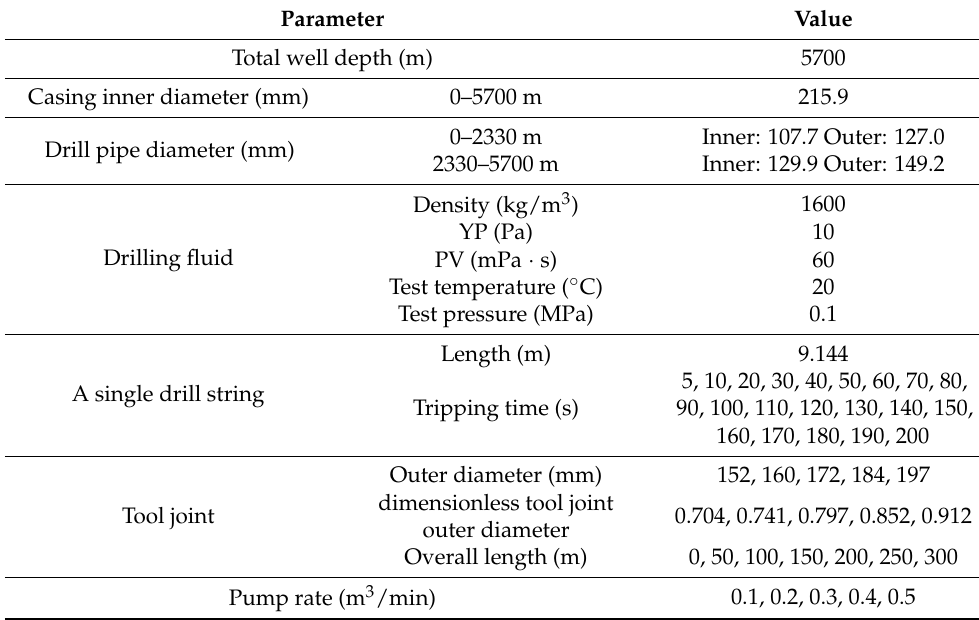
Table 4. Parameter setting of surge pressure